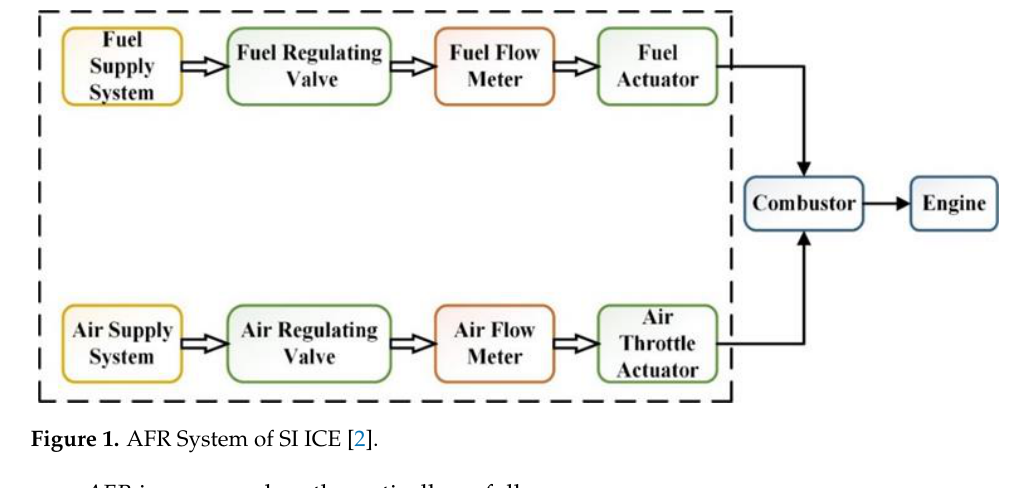
Figure 1. AFR System of SI ICE